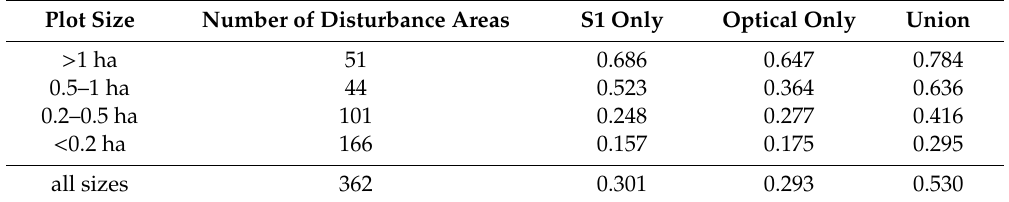
Table 4. Detection accuracy per disturbance patch size for